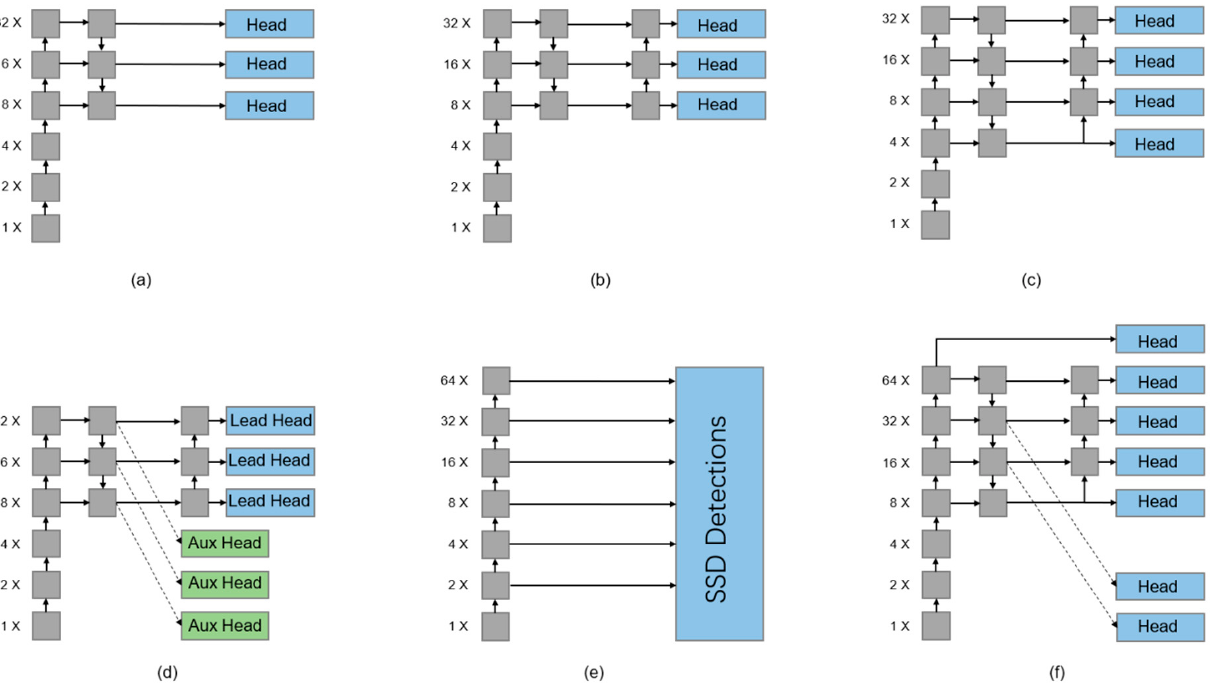
Figure 1. Comparison of the output of various detection heads. ( a ) FPN-based, ( b ) PANet-based, ( c ) TPH-YOLOv5, ( d ), Lead Head + Auxiliary Head, ( e ), SSD-based, ( f ) YOLO-HR (Ours).